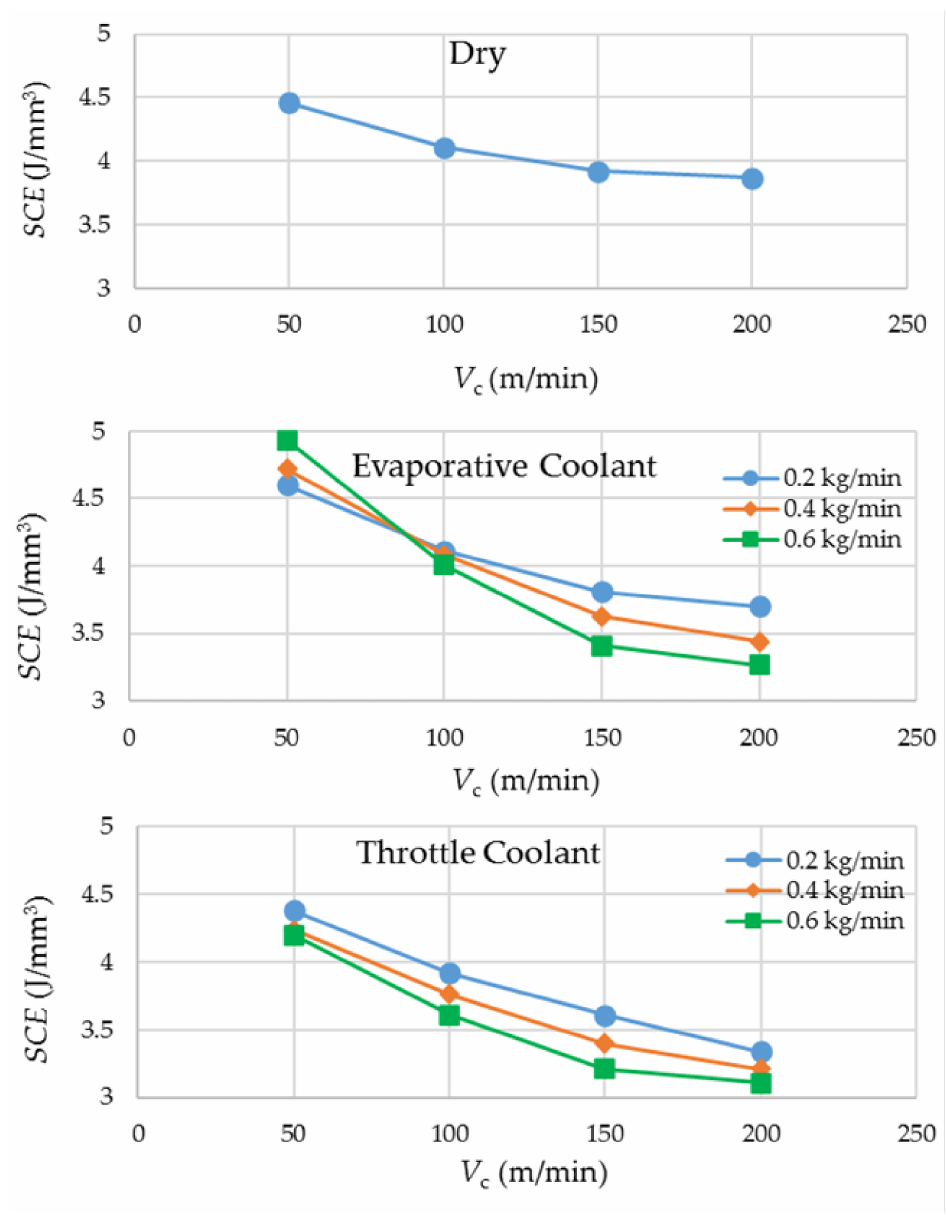
Figure 4. Experimental results regarding specific cutting